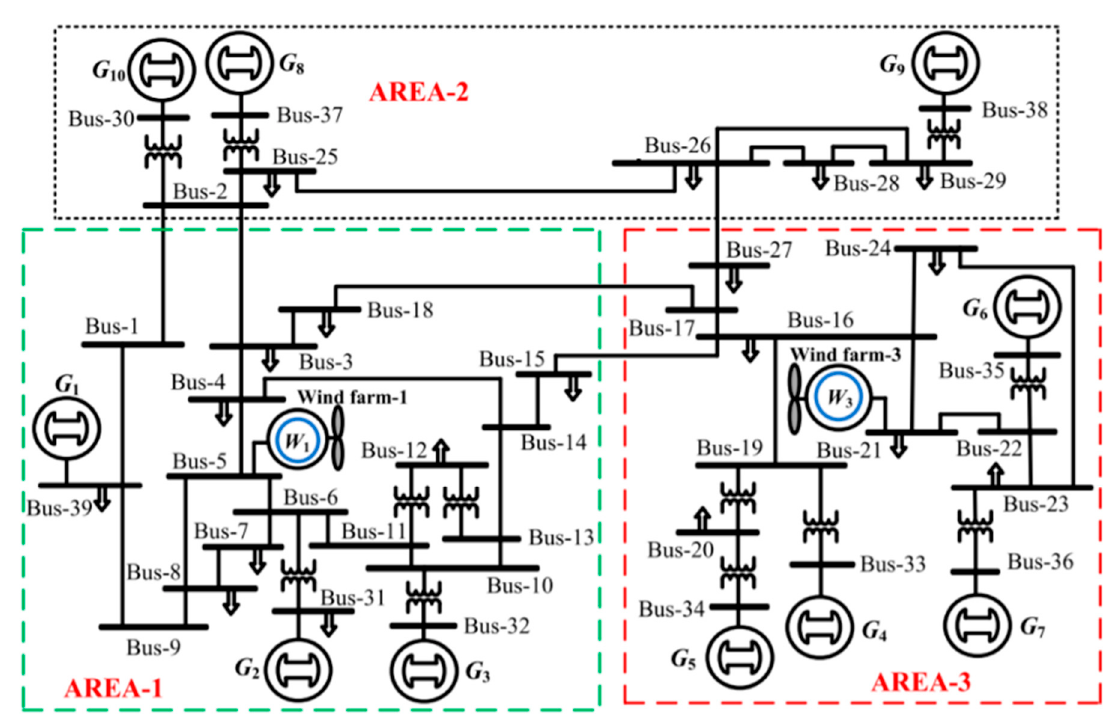
Figure 16. Diagram of IEEE 39-bus integrated with wind plant.